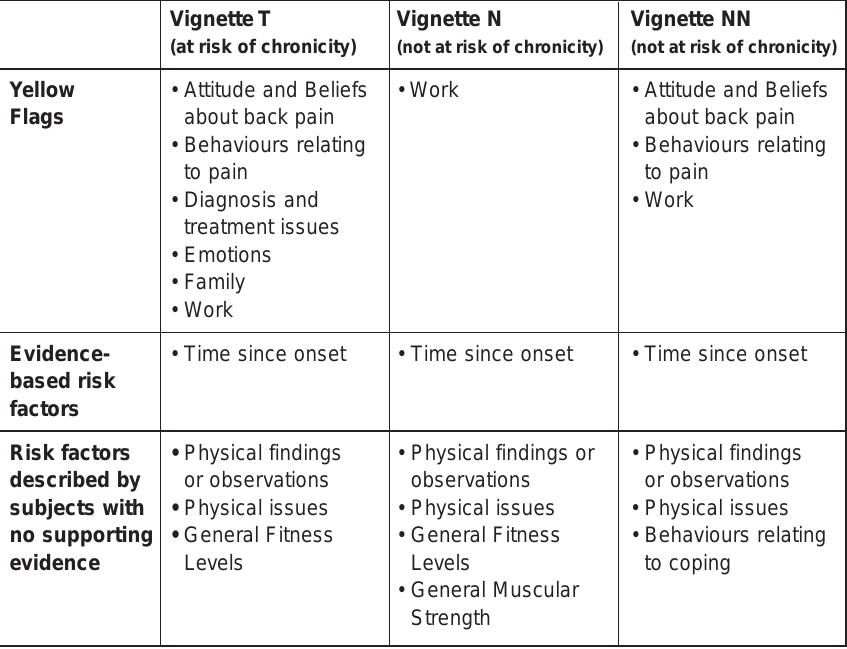
Table 1:Thematic Framework of risk factors described in each vignette.